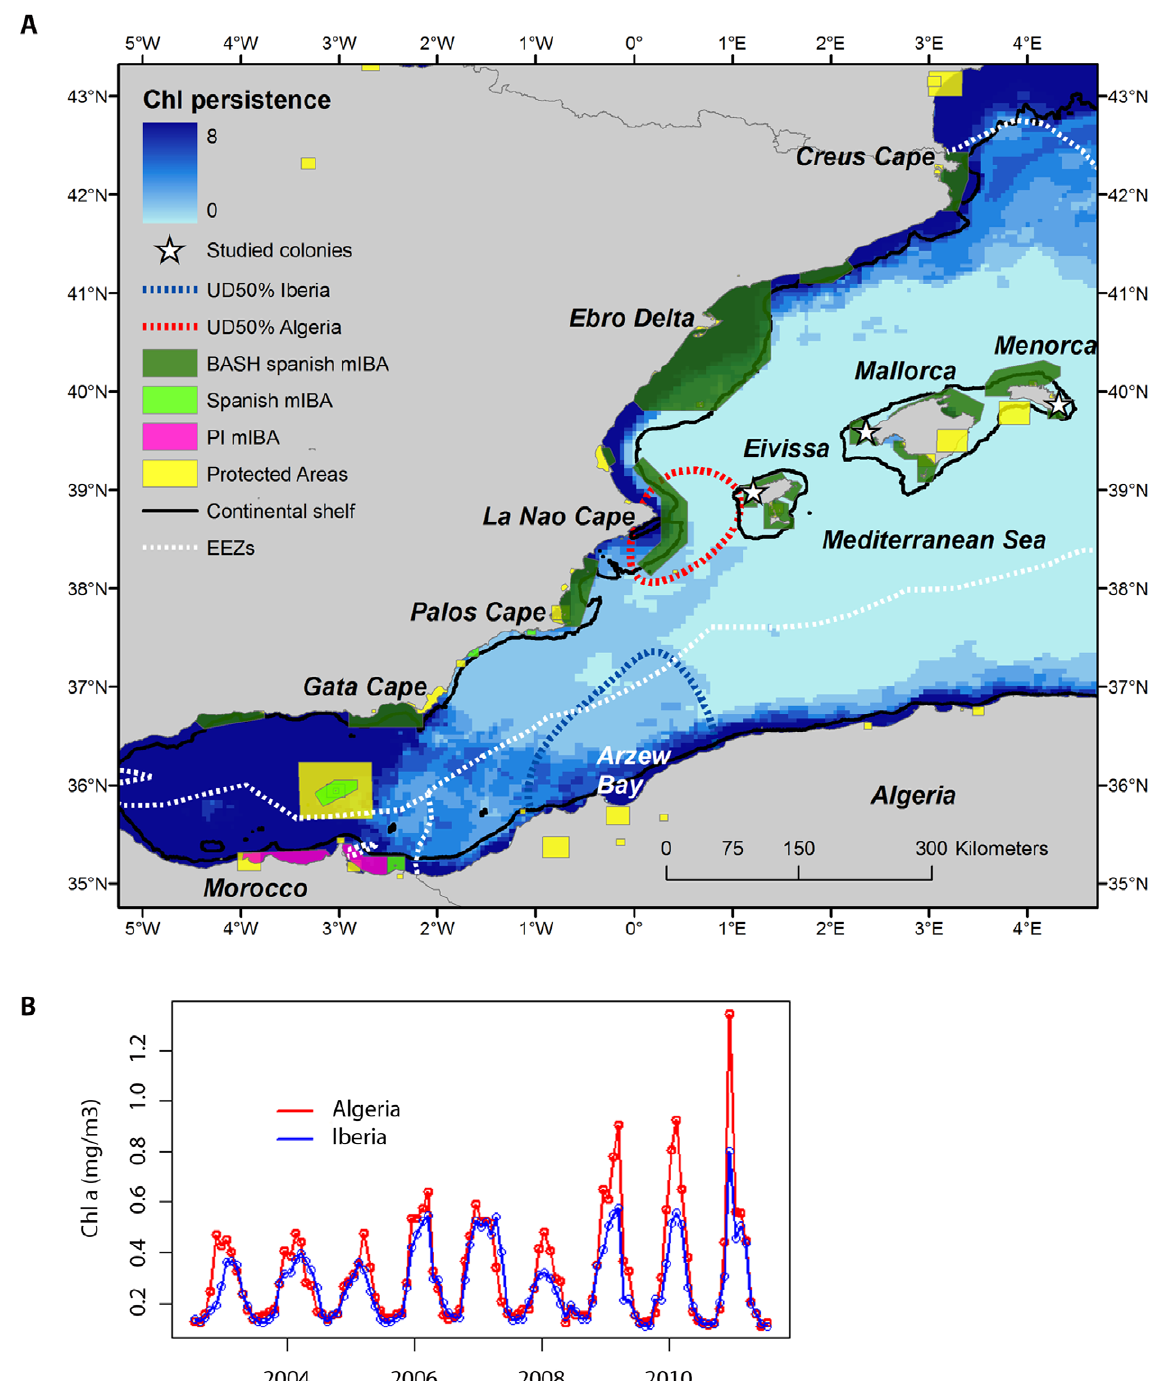
Figure 6. Oceanographic persistence at key marine areas. (a) Persistence of chlorophyll a values in the western Mediterranean during the breeding period (February–June) of Balearic shearwaters. Values were obtained from the MODIS sensor between July 2002 and July 2011. For each pixel, we counted in how many years (maximum of 8) the concentration corresponded to high nutrient concentration ( . 0.3 mg m 2 3 ). Bluer areas correspond to persistent productive areas (check number of years on the scale bar). The position of the studied colony (white triangle), and the two key marine areas (indicated by the 50% UD) around Cape La Nao and Arzew Bay are placed. Limits of the continental shelf (200 m isobath) are defined by the black line, whereas Economic Exclusive Zones are delimited by dotted white lines [57]. In addition, limits of current Protected Areas are placed by yellow polygons in the western Mediterranean [56], as well as Spanish marine Important Bird Areas (mIBAs) for Balearic shearwaters (BASH) (dark green polygons), other Spanish mIBAs (light green polygons) and potentially important (PI) mIBAs in international waters (violet polygons) [18]. (b) Time series of chlorophyll a anomalies estimated for the two main marine areas based on kernel analysis. For each key marine area, we computed the chlorophyll a anomaly by estimating the global mean value and subtracting the global mean value to corresponding month.